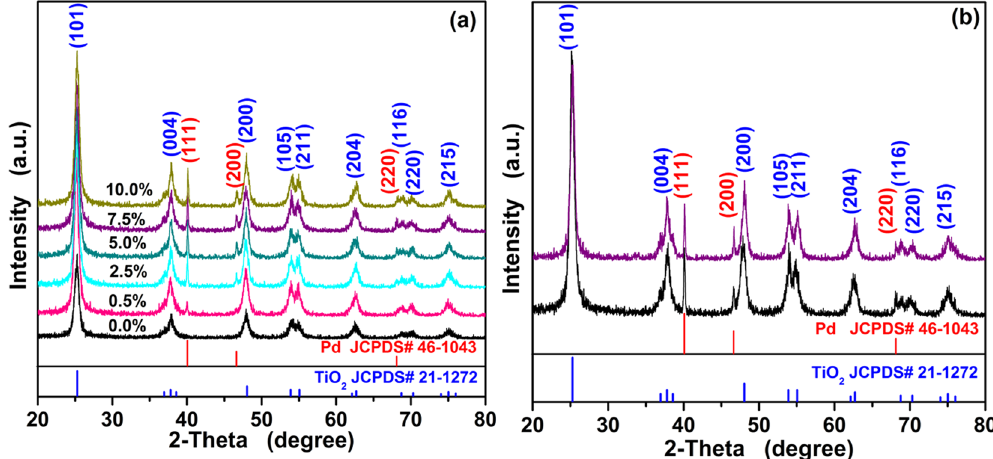
Figure 1. ( a ) The XRD patterns for as-synthesized pure and Pd functionalized TiO 2 nanoparticles; ( b ) XRD patterns for as-synthesized original PTO-4 nanoparticles (the black) and PTO-4 nanoparticles after calcination (the purple) at 400 °C for 1